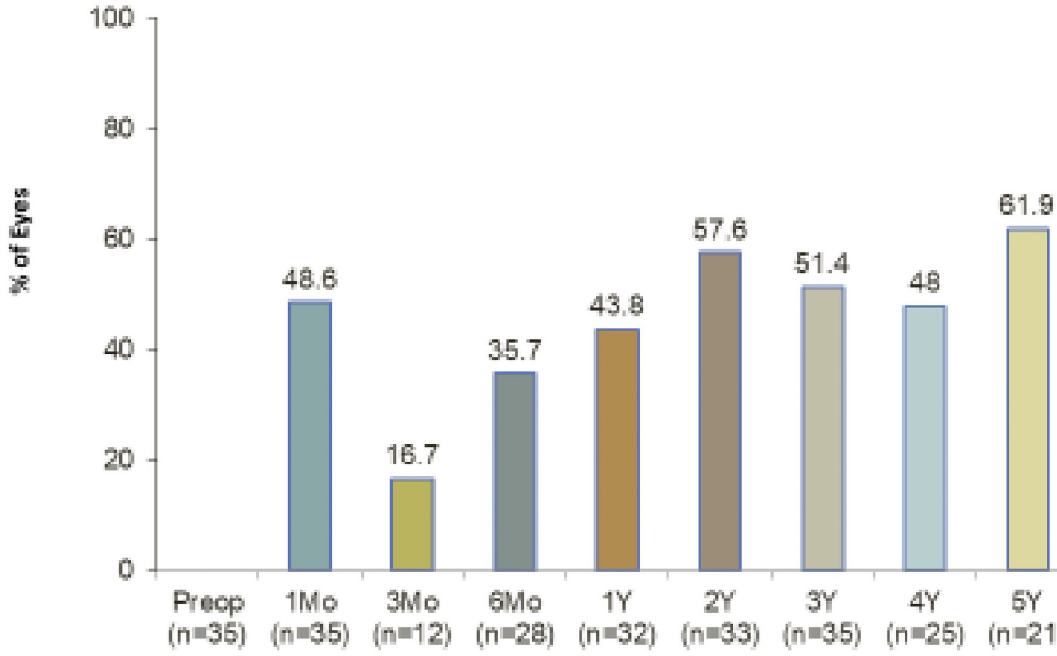
Fig 2. Percent of eyes with 20% or greater IOP reduction vs. preoperative. All eyes at each time point through 5 years.